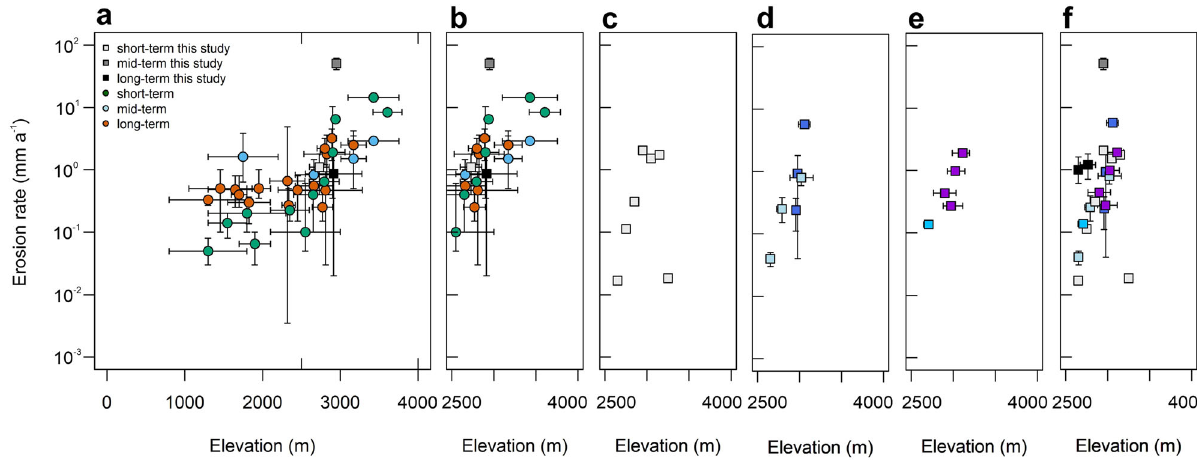
Fig. 5 Erosion rates increase with increasing elevation. a Compiled mean short-term, mid-term and long-term erosion rates from the European Alps, complemented by short-term, mid-term and long-term erosion rates from the Hungerli Valley. Error bars indicate the range in elevation and erosion rate. b The same data as plot ( a ), but for elevations of 2500 m and above only. c Short-term erosion rates only, for the Hungerli Valley. d Mean short-term erosion rates of the Hungerli Valley versus the mean elevation of each deglaciation age class. Error bars show range of erosion rates and 1 st and 3 rd quartile of elevation of deglaciation age class (see Fig. 4c). e Short-term erosion rates of the Hungerli Valley versus mean elevation of MARST class. Error bars show 1 st and 3 rd quartile of elevation of MARST class (see Fig. 4d). f Data from plots ( c - e ) plotted together with mid-term and long-term erosion rates determined from talus slopes. For colour scheme of ( c – f ) see Fig.